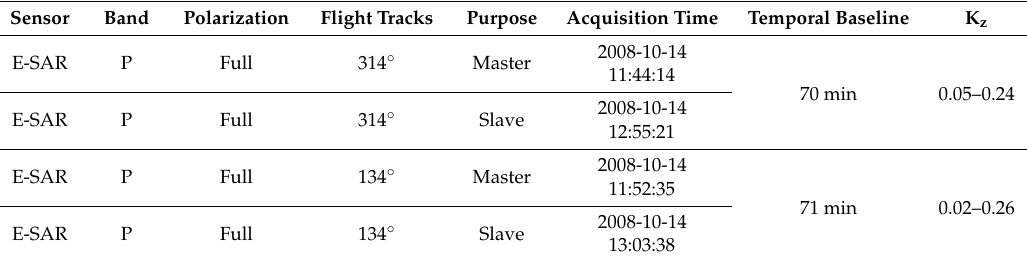
Table 2. Parameters of the SAR data.